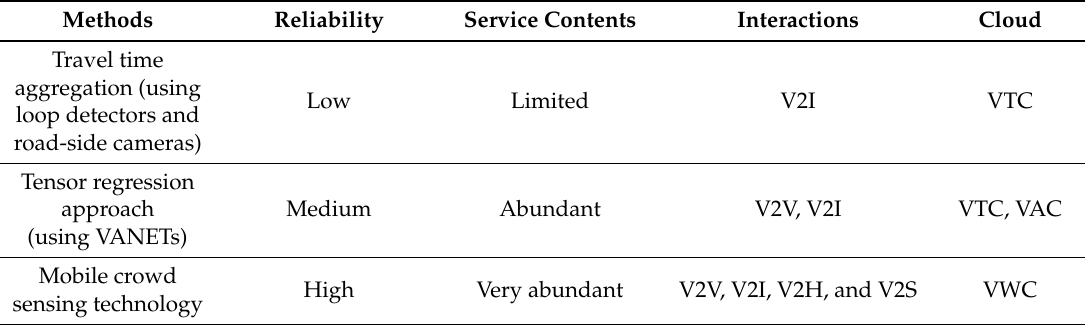
Table 3. A qualitative comparison among the three kinds of traffic congestion alleviation